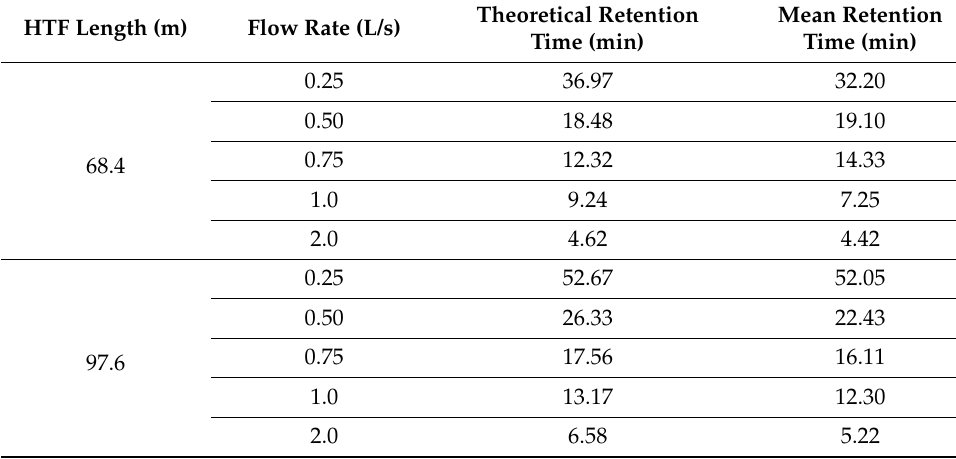
Table 1. Theoretical and mean retention time of